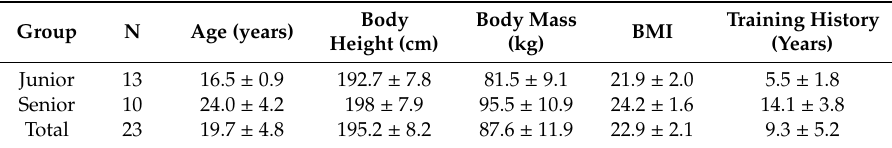
Table 1. Characteristics of Subjects.